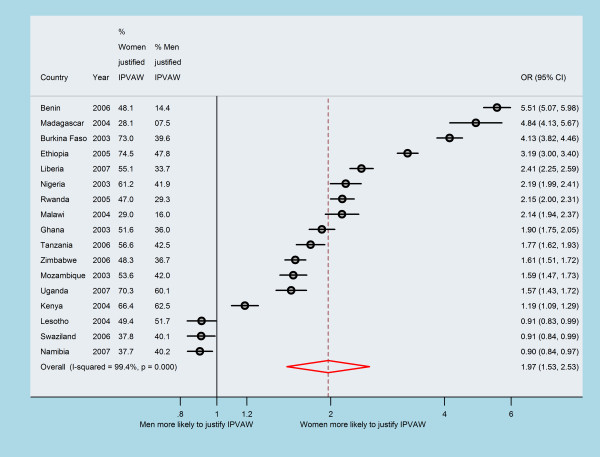
Forest plot of weighted gender-difference in attitude toward intimate partner violence against women of 17 countries in sub-Saharan Africa.